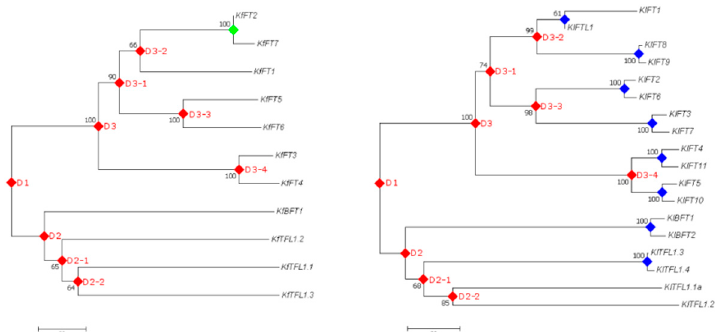
Figure 5. Species PEBP gene family trees in Kalanchoë fedtschenkoi ( left ) and Kalanchoë laxiflora ( right ) with proposed gene duplication events; red marks indicate probable respective gene duplication events (D1 to D3-4) that occurred before divergence of K. fedtschenkoi and K. laxiflora ; blue marks indicate gene duplications observed only in K. laxiflora associated with probable WGD that lead to speciation; and the green mark indicates gene duplication in K. fedtschenkoi that occurred after split between K. fedtschenkoi and K. laxiflora .